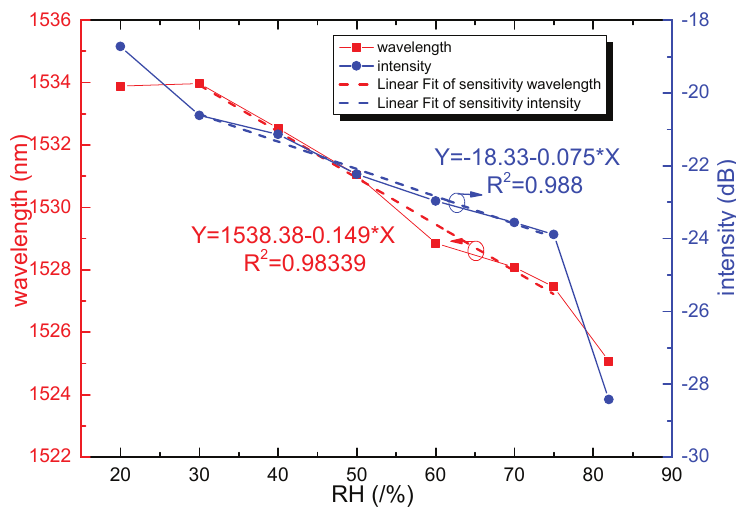
Figure 7. The dependence of the dip wavelength and intensity of the sensor coated by 0.1. wt/vol % in RH range from 30%RH to 75%RH.